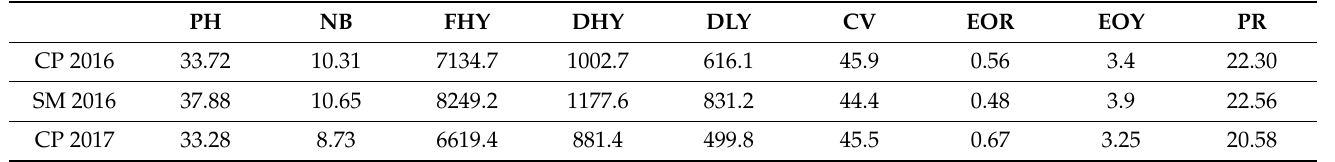
Table 6. The mean values of the morpho-physiological characteristics of Ocimum basilicum L. culti- vated under different IRL and HAD conditions (the means of the mean